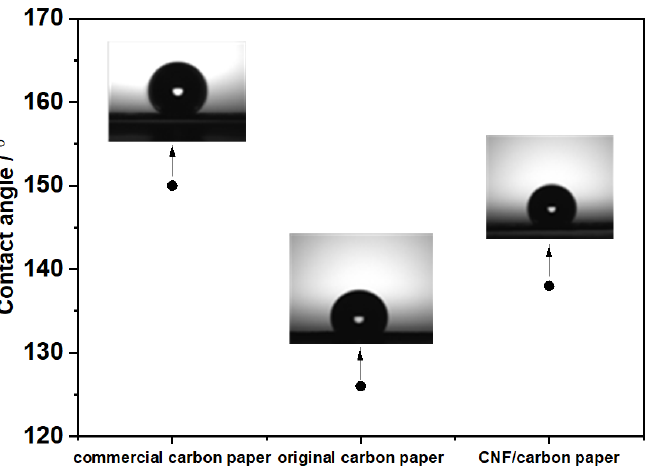
Figure 4. The contact angle of hydrophobic commercial carbon paper, original carbon paper, and CNF/carbon paper.